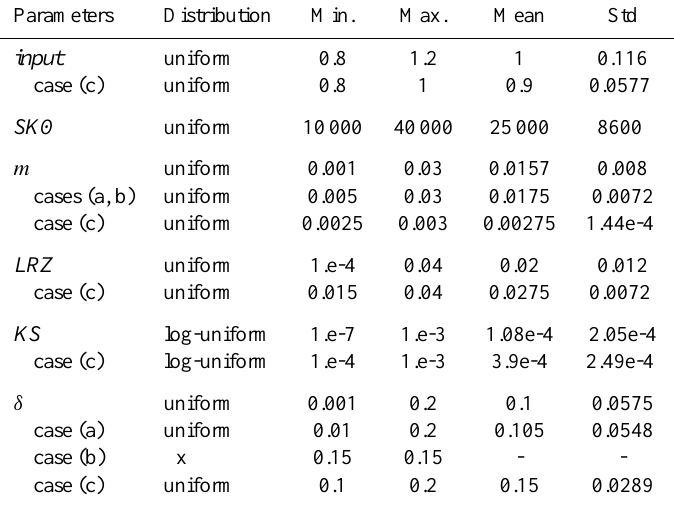
Table 2. Parameter distributions applied in MC calibration of TOPMODEL. For each parameter, the top line shows the ranges for the base calibration exercise, while modified ranges for pre-calibration cases (a,b,c) are specified, when